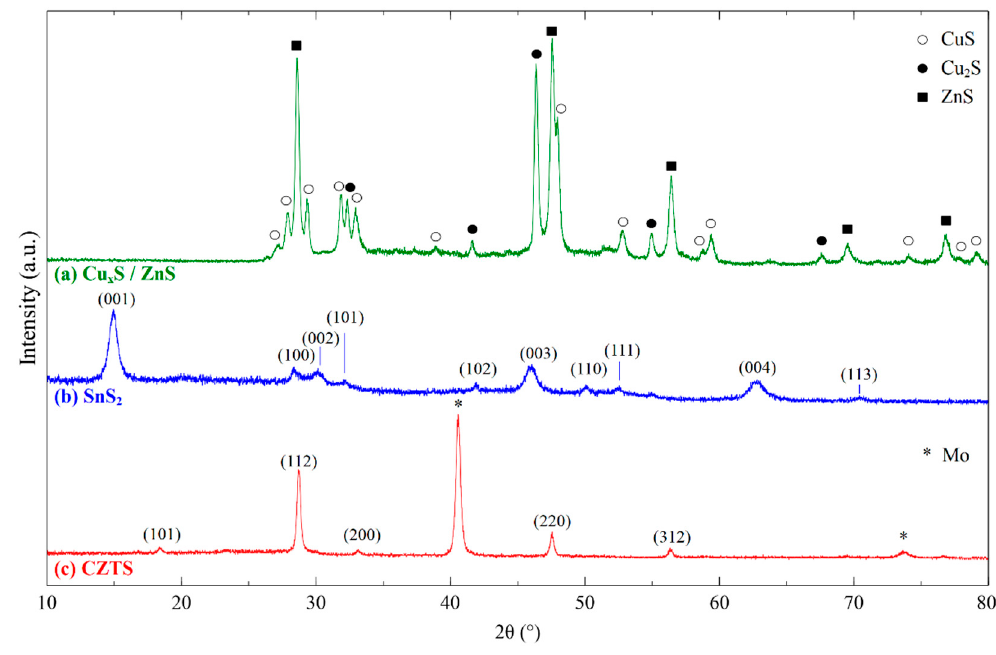
Figure 1. ( a ) XRD patterns of Cu x S, ZnS nanocrystals synthesized from hydrothermal treatment. Reference peaks correspond to sphalerite ZnS, covellite CuS, and digenite Cu 2 S. ( b ) SnS 2 thin film XRD pattern taken from a decomposed thiostannate (IV) complex, matched to berndtite SnS 2 . ( c ) CZTS thin film XRD pattern deposited on a Mo-coated soda lime glass substrate, with peaks matched to kesterite Cu 2 ZnSnS 4 and sputtered Mo of the